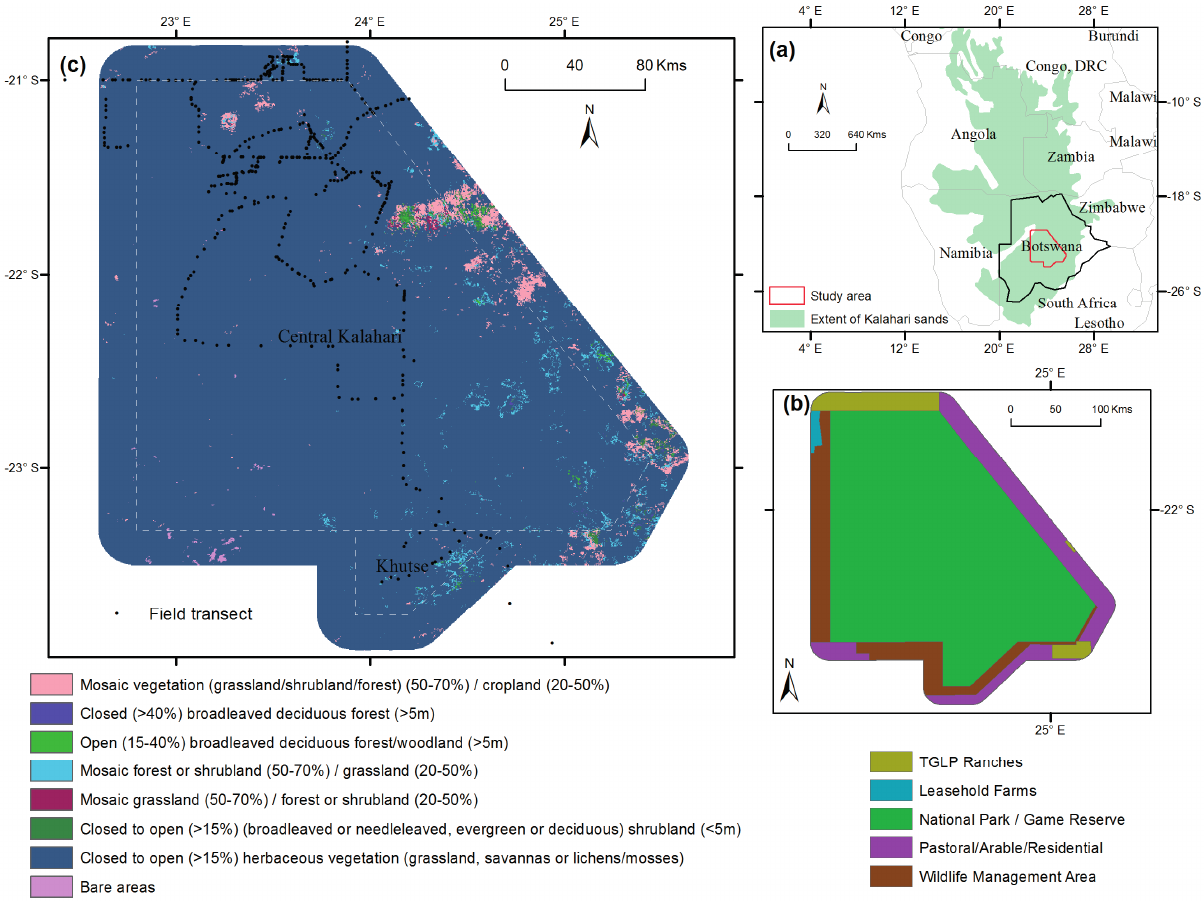
Figure 1. ( a ) The location of Botswana, the extent of Kalahari sand deposits and the study area within southern Africa; ( b ) Land use designations in the central Kalahari; ( c ) Land cover map of the central Kalahari as represented by the GlobCover 2009